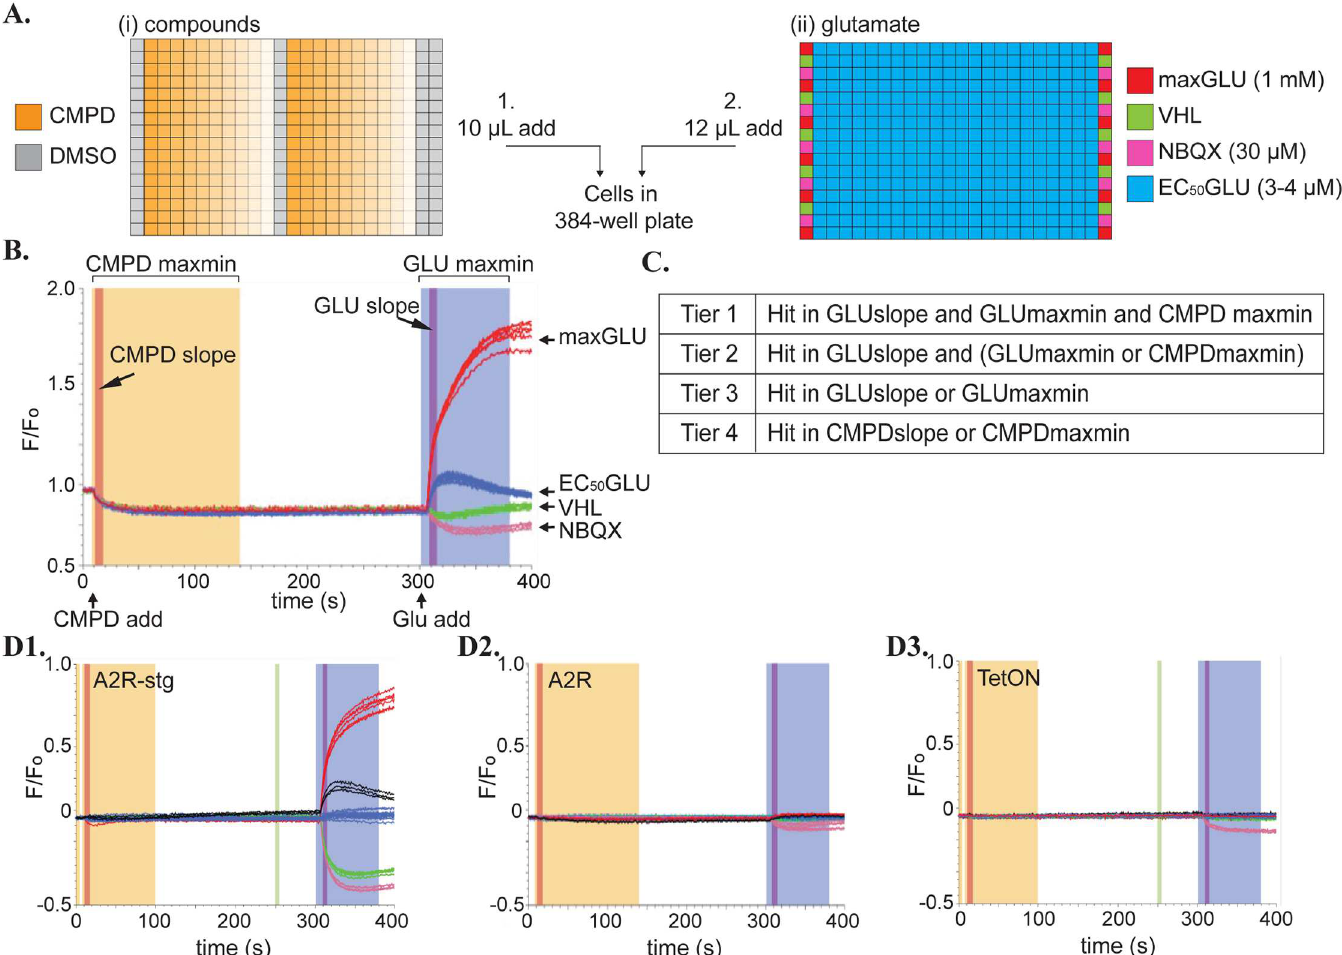
Fig 1. Configuration of VSD assays. (A) Arrangement of wells in compoundand glutamate plates added to cells by the FDSS. (i) Compounds(orange) are addedat 10 μ M concentration in initial screen and as a 40 μ M– 10nM curve (decreasing color saturation) for CRC testing. (ii) Controls to determine a Z’ for each plate line the edgesof the glutamateplate. Positive control = 1mM glutamate(maxGLU, red), 1X FLIPR Blue dye vehicle(VHL, green), negative control = 30 μ M NBQX (NBQX, pink). EC 50 glutamate(3–4 μ M) is addedacross the plate (EC 50 GLU, blue) with columns 2 and 23 used as EC 50 GLU controls with DMSO. DMSO control was moved to column 12, in CRC plates. (B) Normalizedfluorescence data (ratio of the F/F o ) readout for the FDSS on a VSD experiment showingthe compoundand glutamateadditionsat 10 sec and 300 sec, respectively. Controls are shown in colors corresponding to their colors in the glutamateplate in A(ii). Different hit windowsare shaded in dark orange(CMPDslope), light orange(CMPDmaxmin), purple(GLUslope), and violet (GLUmaxmin). (C) Definitionof Tier 1–4 hits in our initial screen. Hits were determinedas those compounds that deviatedfrom the mean of the test population EC 50 GLU by more than three standarddeviations in the windowsspecified on a per plate basis. (D) Example of a compound(black trace) that hit on (1) A2R-stg cells but not on (2) A2R or (3) TetON cells. Controls are maxGLU (red), vehicle(green), 30 μ M NBQX (pink), all normalized to EC 50 GLU